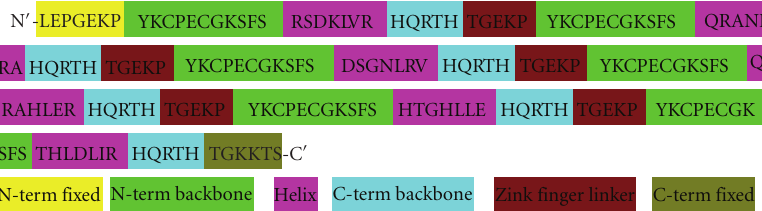
Figure 3: The 176 amino acid sequence of the AZP. Di ff erent Motifs were shown by distinct background colors.